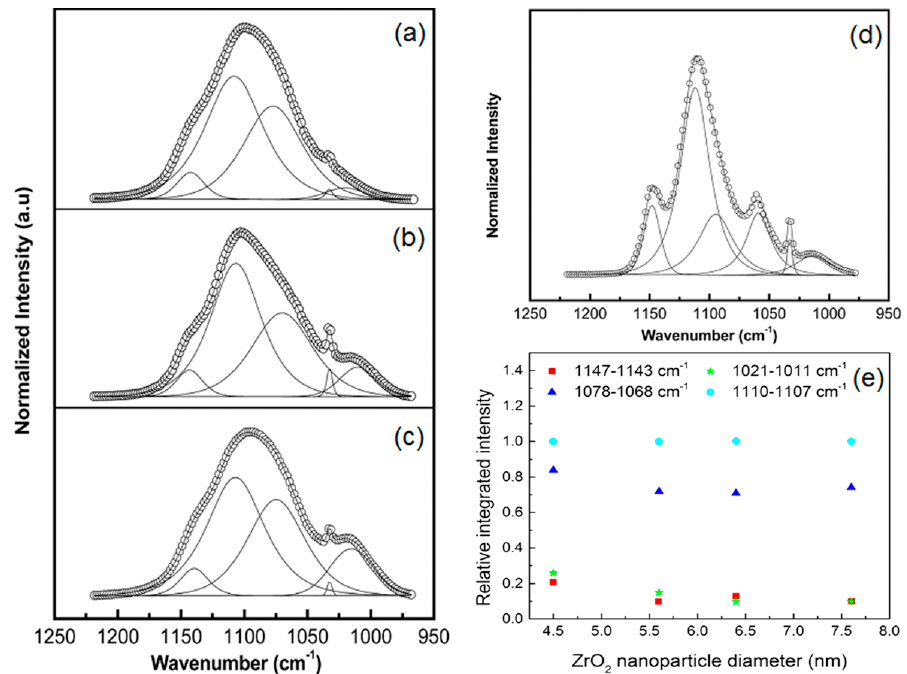
Figure 5. Deconvolution of Fourier Transform Infrared (FTIR) spectra for C-O-C band in ( a ) PEO-NaClO 4 (EO:Na + = 25); ( b ) solid composite polymer electrolyte PEO-NaClO 4 (EO:Na + = 25) with ZrO 2 nanoparticles (d = 4.5 nm); ( c ) solid composite polymer electrolyte PEO-NaClO 4 (EO:Na + = 25) with ZrO 2 nanoparticles (d = 7.6 nm); ( d ) neat PEO in the region of 1250–950 cm − 1 ; ( e ) Variation of